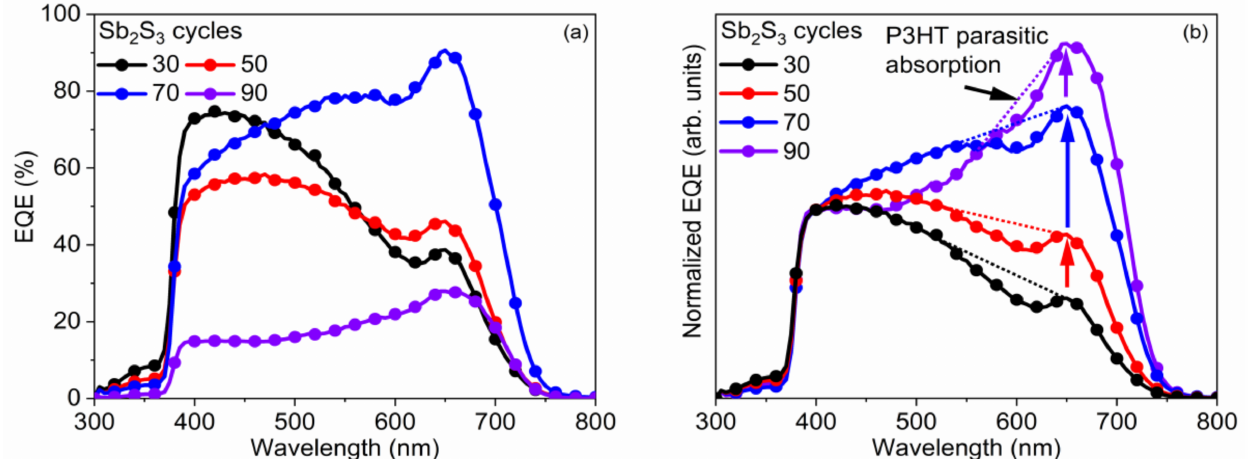
Figure 10. ( a ) EQE vs. wavelength and ( b ) normalized EQE to its value at 400 nm vs. wavelength of the best ETA solar cells made of ZnO/TiO 2 core–shell NW heterostructures covered with a Sb 2 S 3 shell grown by CSP, using 30, 50, 70, and 90 cycles. The dotted lines are a guide-to-the-eye, lying roughly between the absorption onset of P3HT at 650 nm on one side, and the absorption maximum of P3HT, at 525 nm, on the other side.